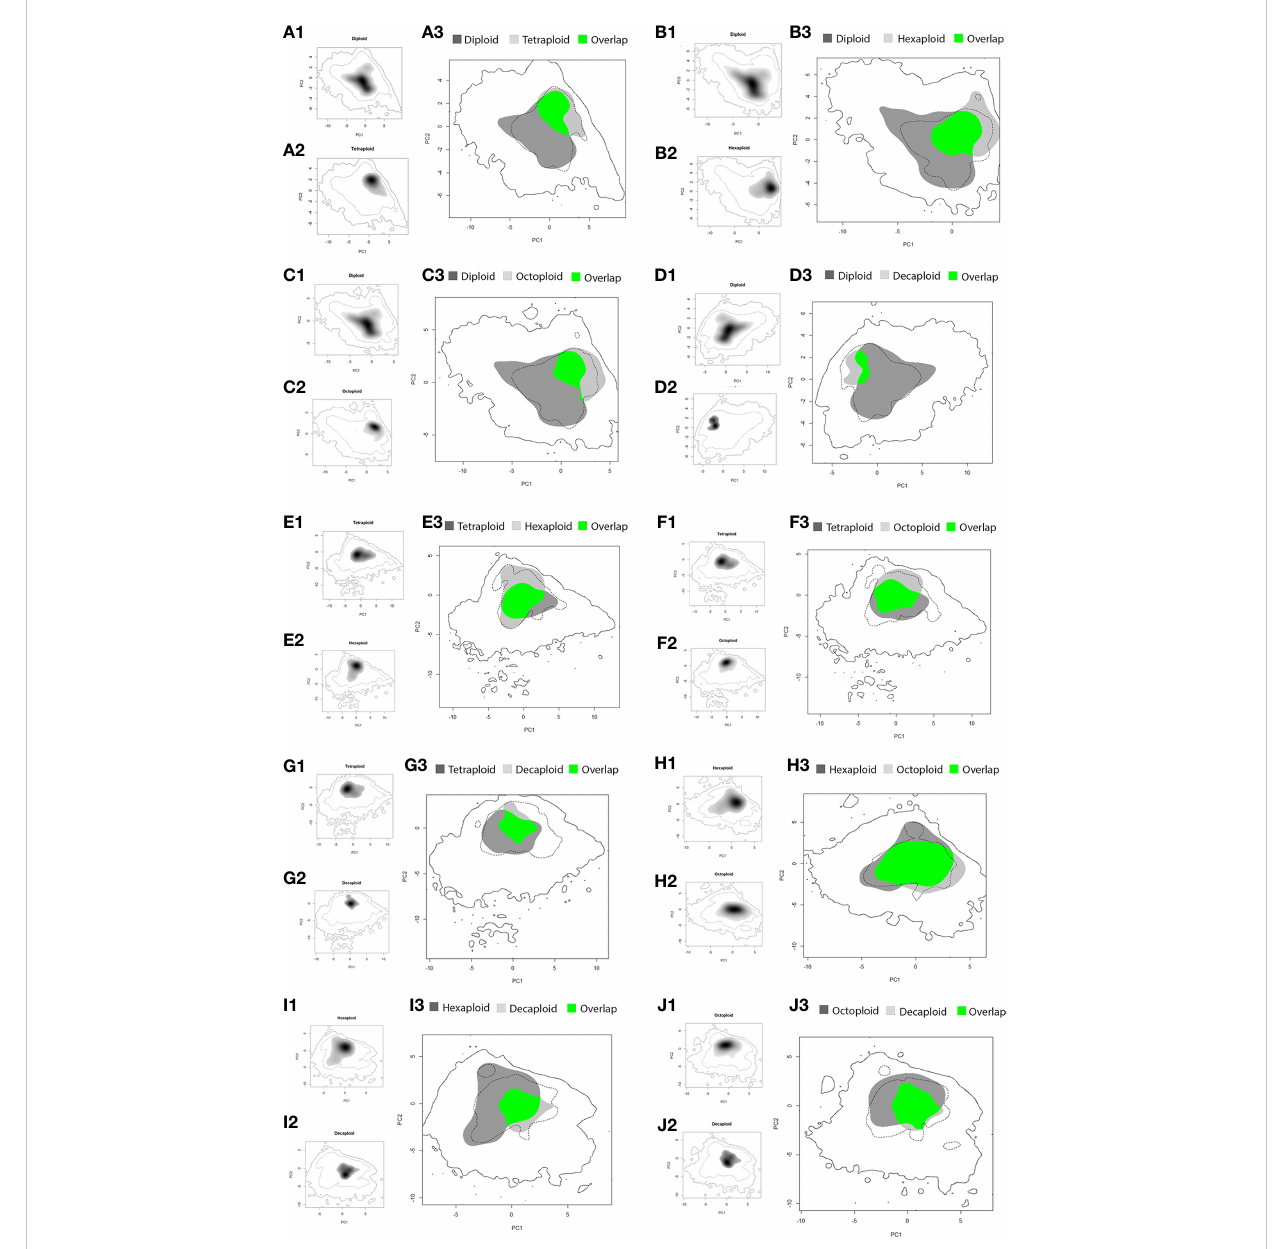
FIGURE 2 Comparison of ecological niche models for Linum suffruticosum s.l. pairs of cytotypes, based on the PCA of selected variables; diploid vs tetraploid (A1-A3) , diploid vs hexaploid (B1-B3) , diploid vs octoploid (C1-C3) , diploid vs decaploid (D1-D3) , tetraploid vs hexaploid (E1-E3) , tetraploid vs octoploid (F1-F3) , tetraploid vs decaploid (G1-G3) , hexaploid vs octoploid (H1-H3) , hexaploid vs decaploid (I1-I3) , octoploid vs decaploid (J1-J3) ; coloured areas represent suitable habitats for cytotype 1 (light grey) and cytotype 2 (dark grey) and overlapping areas (green). The continuous line corresponds to the whole climatic space, while the dashed line indicates the 75 th